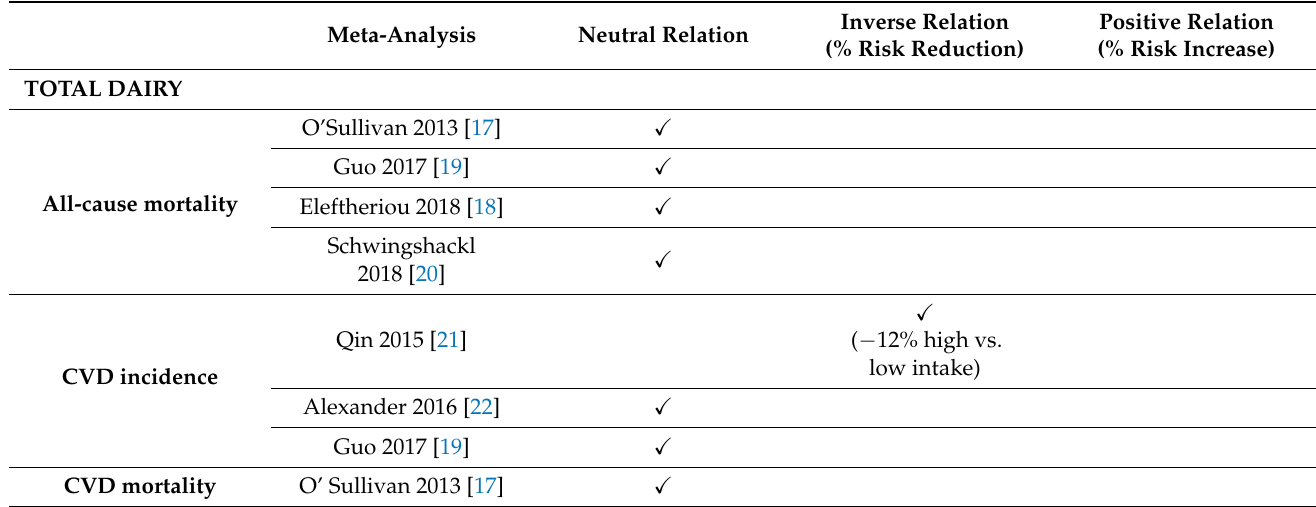
Table 1. Summary of the available meta-analyses of prospective cohort studies on the relation between dairy products and CV hard endpoints or all-cause